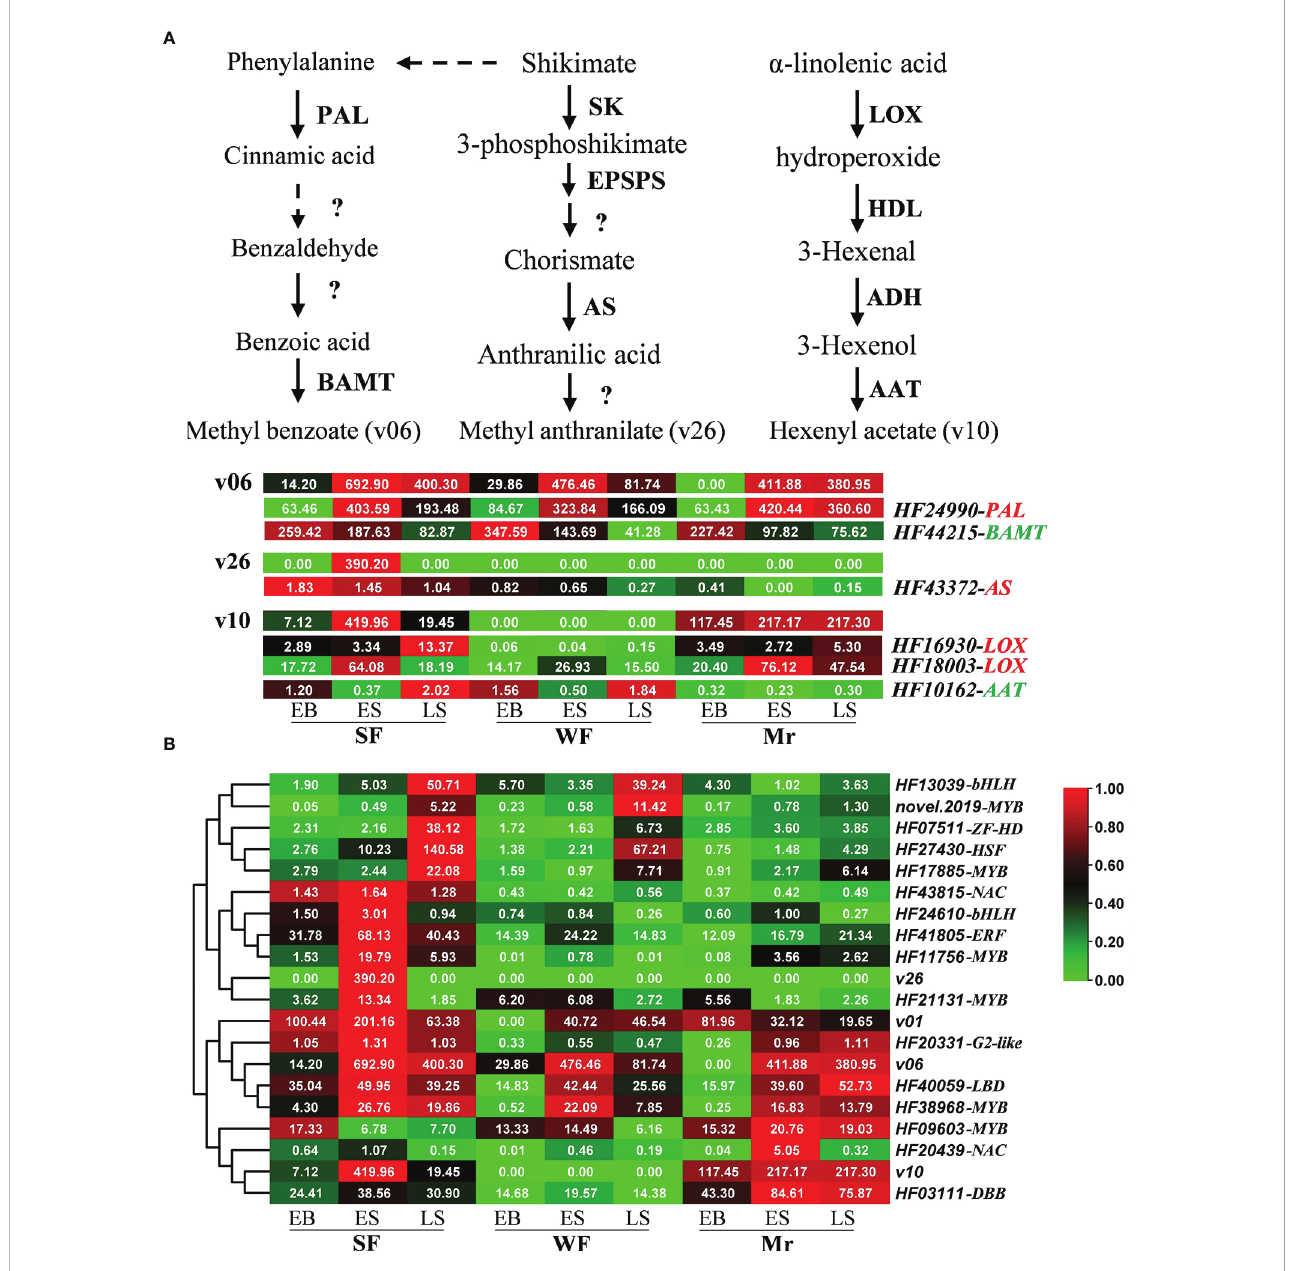
FIGURE 6 Expression patterns of genes associated with fl oral volatiles. (A) Expression patterns of homologous genes corresponding to the synthetic pathway of methyl benzoate (v06), hexenyl acetate (leaf acetate, v10), and methyl anthranilate (v26) were analyzed at the different developmental stages of strongly fragrant (SF), standard (Mr), and weakly fragrant (WF) fl owers. Continuous arrows depict a one-step enzymatic reaction. (B) Identi fi cation of transcription factors potentially associated with fl oral volatiles based on the correlation network. In the heatmap, red and green colors represent the maximum and minimum values, respectively, and each line is independent. The fi rst list on the right is the volatile ID and gene ID, and the second list is the gene name. The red and green backgrounds behind the gene name indicate a positive and negative correlation, respectively. Data represent the means (n=